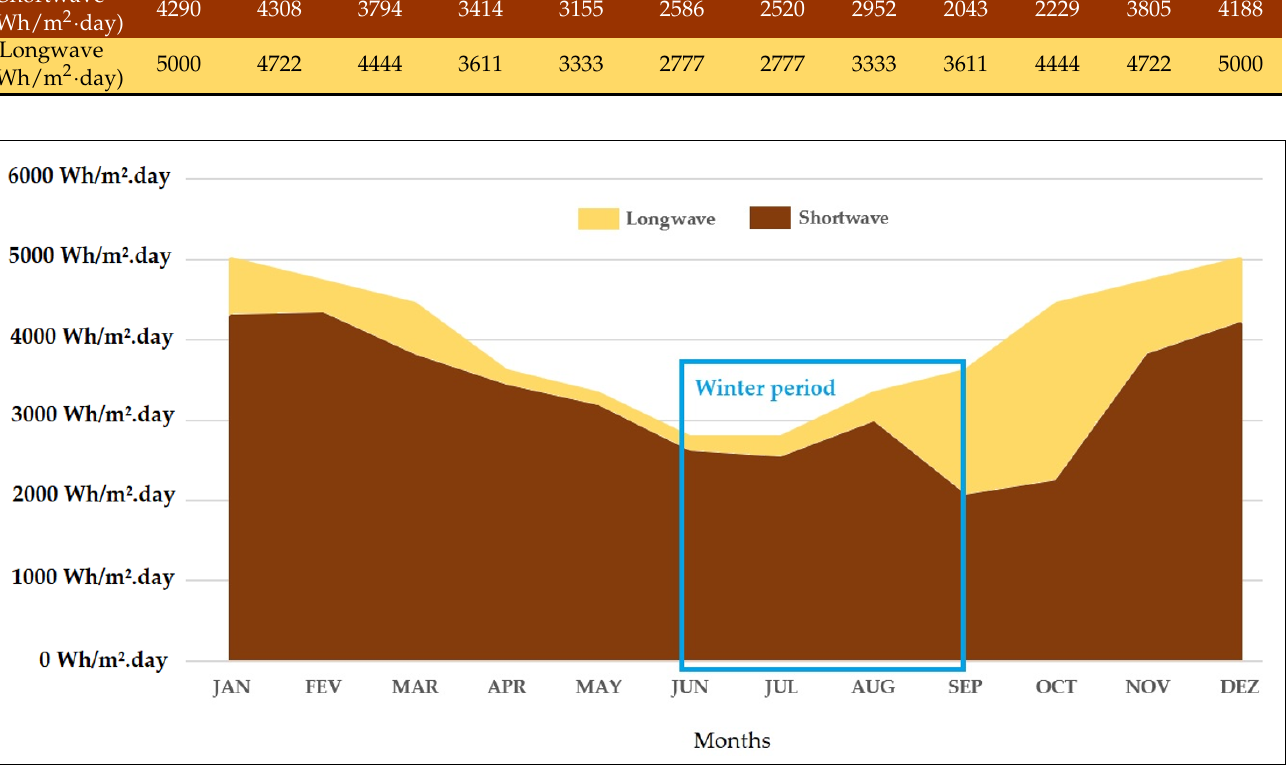
Figure 5. Monthly variation of the shortwave and longwave solar radiation in Balneário Camboriú/SC—Brazil (Wh/m².day).